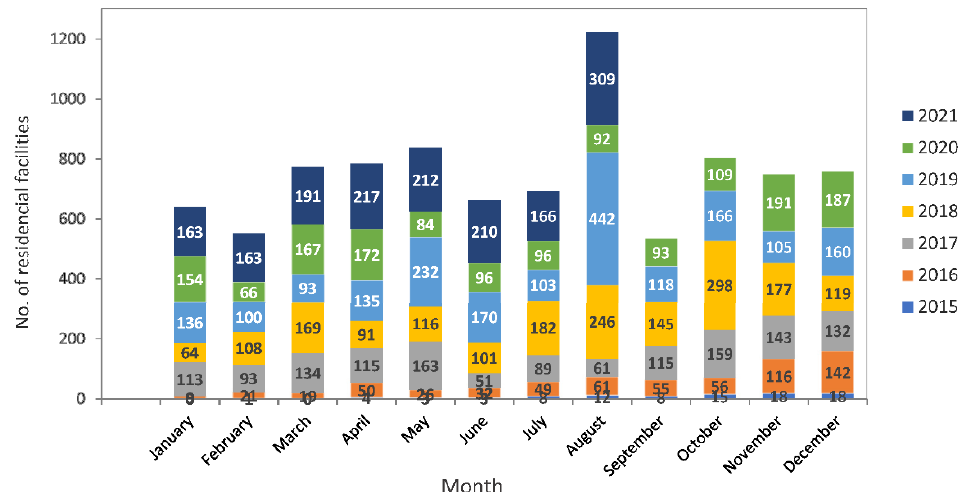
Figure 6. No. of residential facilities declared before the SEC at national level according to Law No.